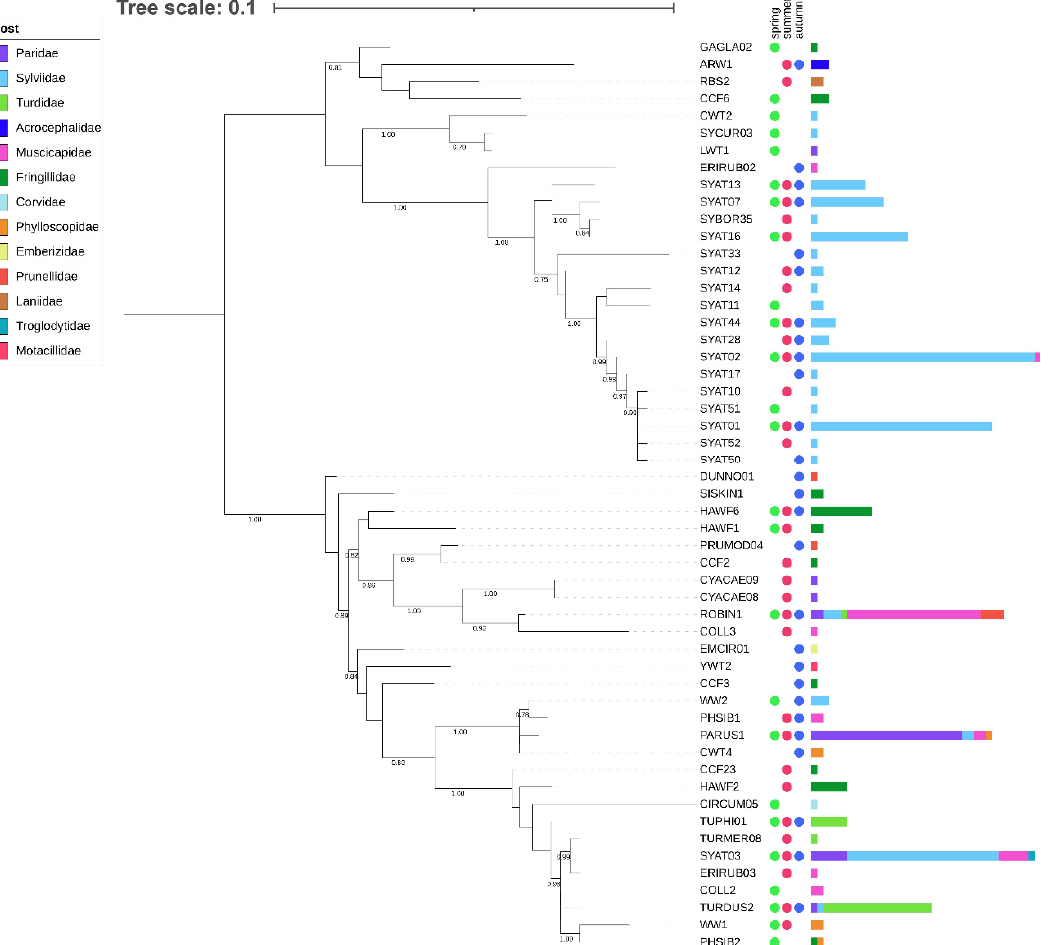
Figure 1. Maximum likelihood tree of avian haemoproteid lineages detected at the study site in Slovakia based on a 478 bp mtDNA region of the cytb gene. The tree was constructed based on the best-fit substitution model (TIM2 + F + I + G4) and is rooted at midpoint. The branch support was assessed using the aBayes test, and the corresponding values are shown for branches >75% support. After each lineage, circles denote the seasonal dynamics of the lineage’s occurrence and horizontal bars denote the lineage’s abundance in their avian hosts of 13